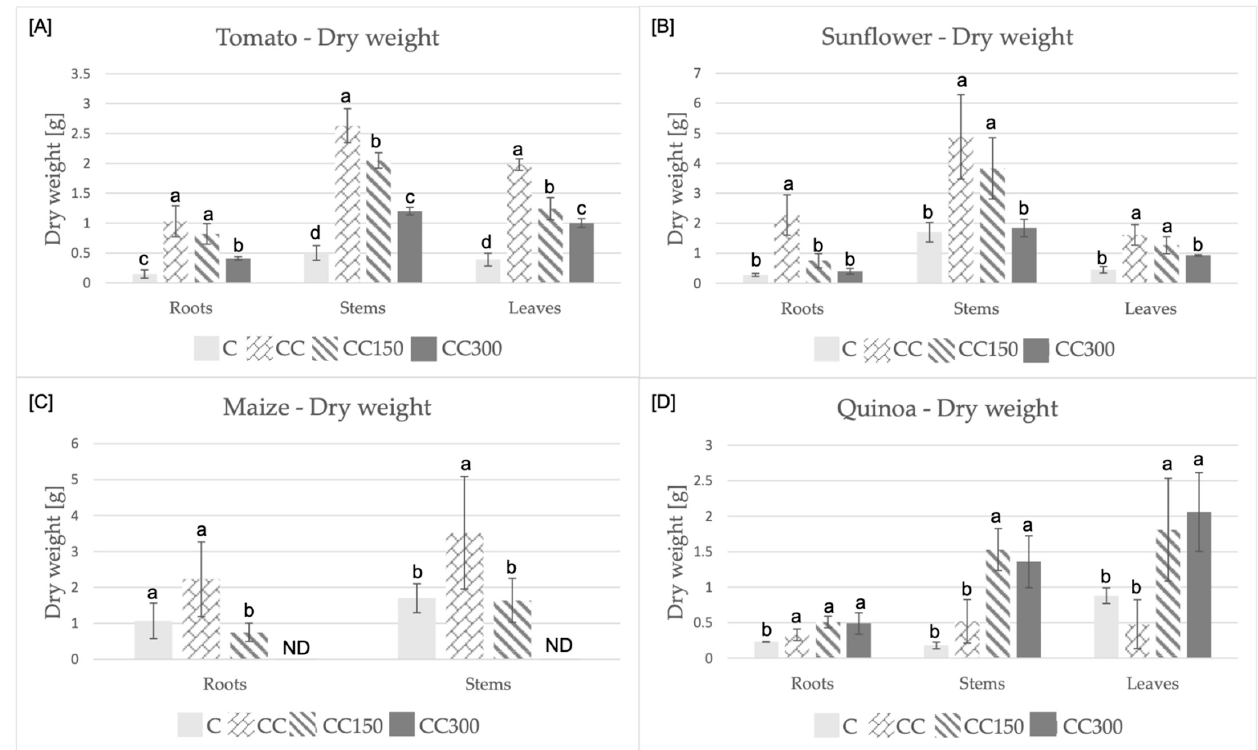
Figure 2. Dry biomass produced by the four crops: ( A ) tomato, ( B ) sunflower, ( C ) maize, ( D ) quinoa in the different conditions. Statistical significance assayed for p = 0.05. The comparison was performed within each organ. The letters a, b, c, d indicate the statistically significant differences. ND indicates not